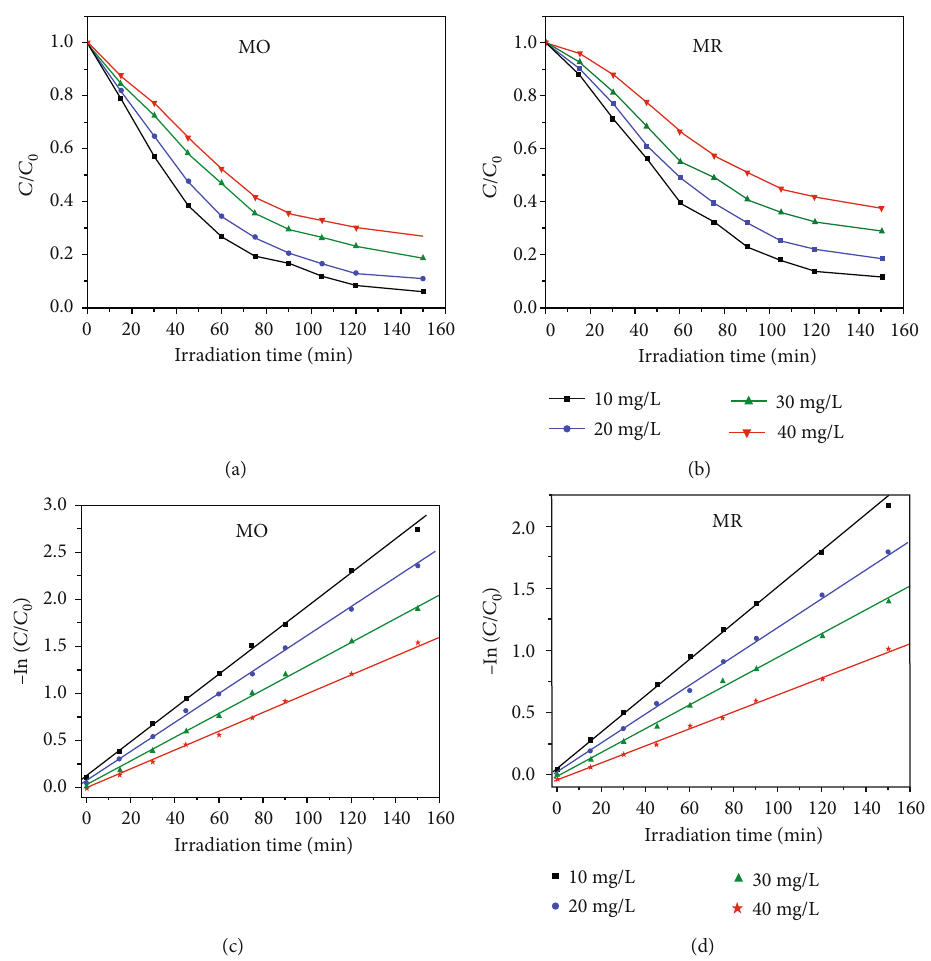
Þ vs. irradiation time 0